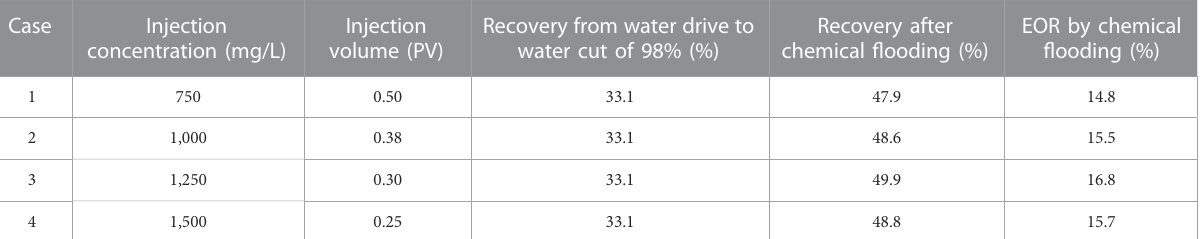
TABLE 4 EOR amplitudes under different injection concentrations.